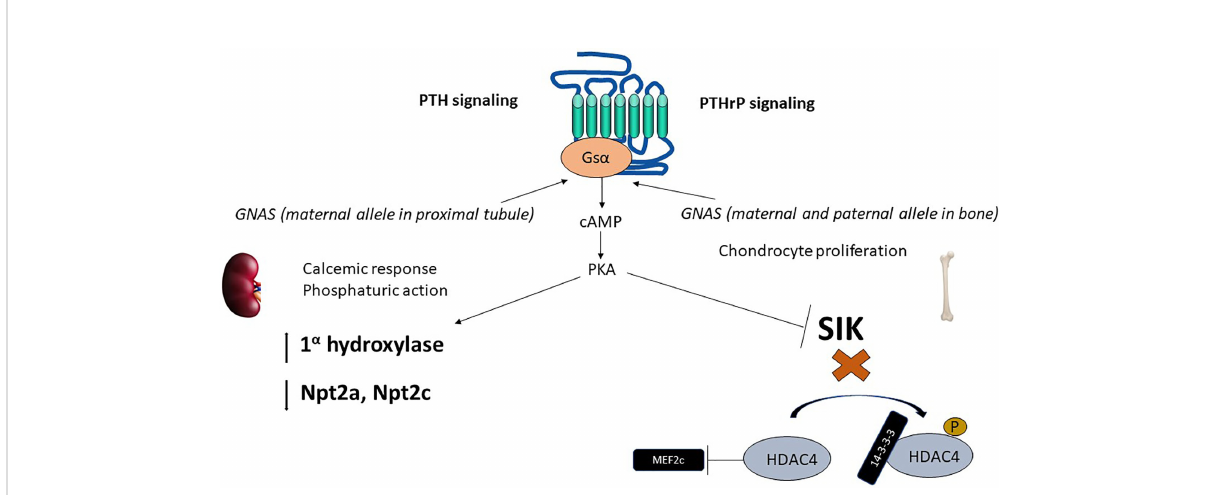
FIGURE 1 Epigenetics of PTH and PTHrP signaling. The parathyroid hormone receptor (PTH1R) mediates the actions of two ligands, PTH and PTHrP, with independent roles in calcium homeostasis and bone developments, respectively. PTH1R main signaling pathway in response to PTH or PTHrP requires activation of the a subunit of the heterotrimeric stimulatory G-protein (Gs a ). Gs a is encoded by GNAS, a complex locus that normally undergoes methylation on the maternal side (for normal expression of Gs a ). In the proximal tubule, Gs a is almost exclusively derived from the maternal side during adult life. cAMP generation results in phosphaturic action (via downregulation of phosphate transporters Npta and Npt2c) and vitamin D activation. In the developing bone, downstream of Gs a , cAMP production activates PKA and inhibits SIK thereby exerting a control in MEF2c, which results in chondrocyte proliferation. PTH, parathyroid hormone; PTHrP, parathyroid hormone related peptide; PKA, protein kinase A; SIK, salt inducible kinase; HDAC, Histone deacetylase; MEF2, myocyte enhancer factor.